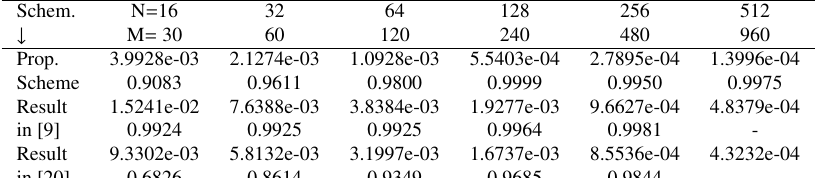
Table 8. Example 4.2, comparison of ε -uniform error and ε -uniform rate of convergence. Schem.